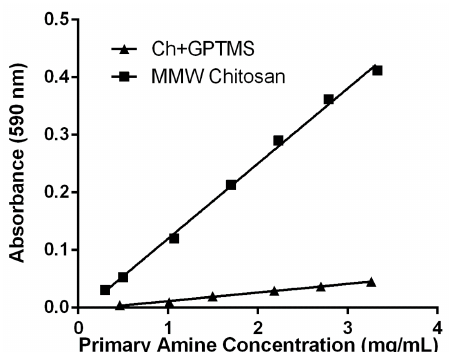
Figure 4. Quantitative analysis of covalent coupling between chitosan and 3-glycidyloxypropyltrimethoxysilane (GPTMS) by ninhydrin assay. In finely ground aqueous suspensions of coupled material (Ch + GPTMS) and uncoupled chitosan (MMW Chitosan), ninhydrin reagents selectivity for primary amines was measured by optical absorbance at 590 nm. The degree of covalent coupling between chitosan and GPTMS was measured to be 91% and maintained throughout the study